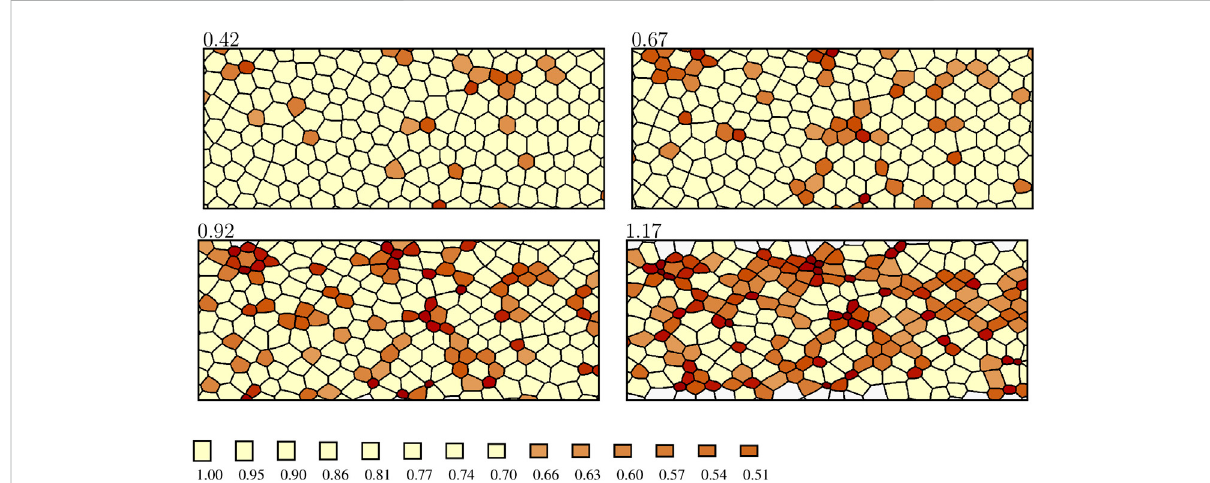
FIGURE 7 Formationofcellularconstrictionchainsduringthesimulatedconstrictionprocess.ThelabelingisthesameasinFigure6,exceptthatthecolor scaleistruncatedtovisualizetheformationofchainsofstronglyconstrictedcells( r A ≤ 0.66).Theanteroposterioraxisishorizontal.Alargerportionof thesimulation domain is depicted thanthe onerepresented in Figure 6to show the development of an elongated percolating cluster oriented inthe anteroposterior direction.